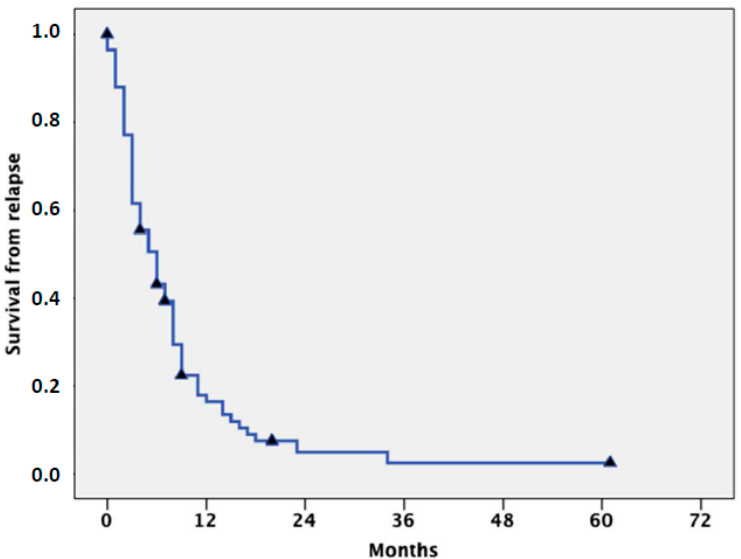
Figure 1. Survival from relapse of 80 consecutive relapsed acute myeloid leukemia (AML) elderly patients, previously treated with intensive chemotherapy (median age: 69 years, range: 65–84).